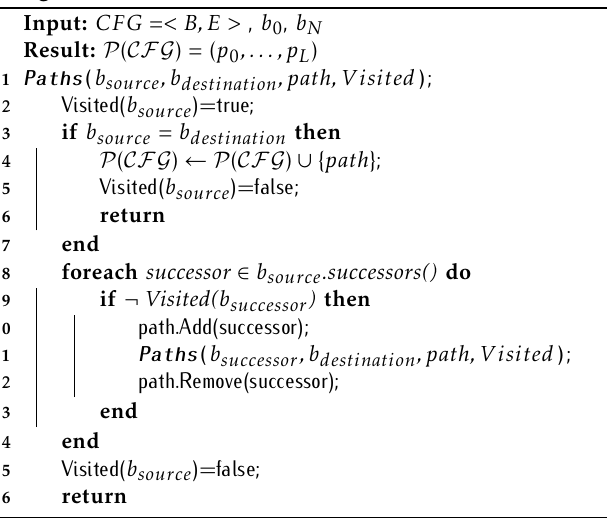
Algorithm 2.2: Path